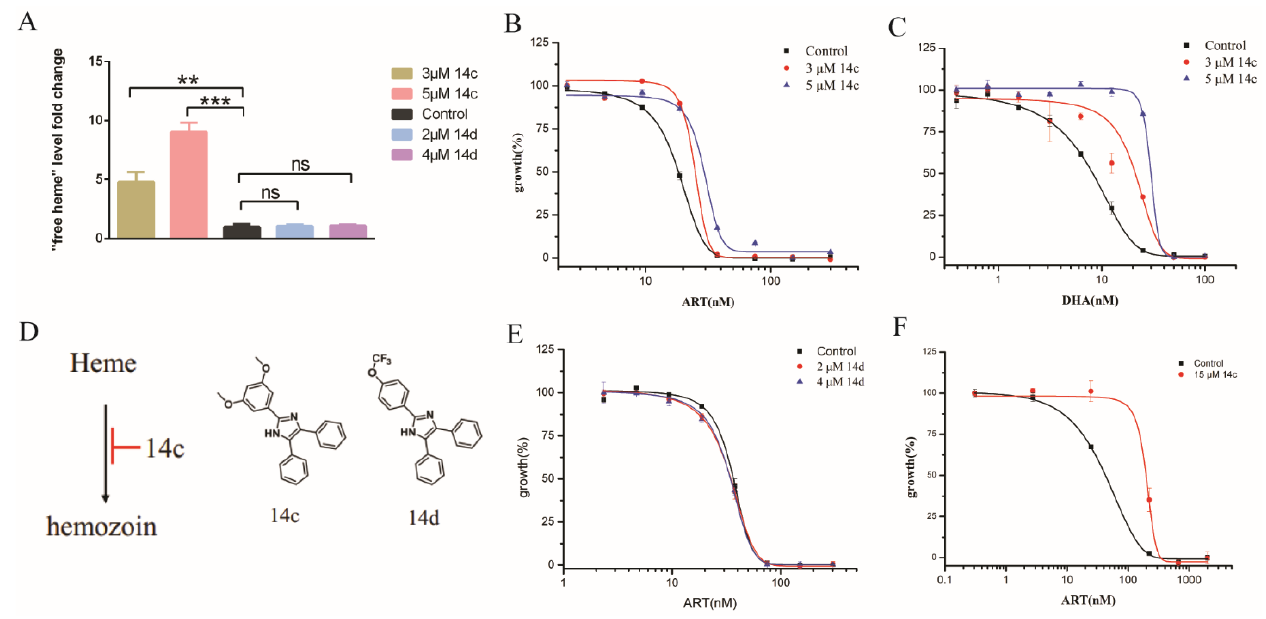
Figure 2. Hemozoin inhibition enhanced free heme levels and decreased sensitivity of artemisinin. ( A ) 14c but not 14d increased “free heme” levels in P. falciparum . Data are mean ± SD of three exper- iments. ( B ) EC 50 of artemisinin was increased with 14c. ( C ) 14c obviously decreased sensitivity of parasites to dihydroartemisinin. ( D ) Chemical structure of 14c and 14d; ( E ) 14c analogue 14d had little effect on EC 50 of artemisinin. ( F ) EC 50 of artemisinin could also be significantly changed with higher dosages of 14c in the short-pulse assay. Early ring-stage parasites were used. Data are mean ± SD of three experiments. The data were analyzed by GraphPad Prism. ** p -value < 0.005, *** p - value < 0.0005, and ns = no significant change ( p -value > 0.05).